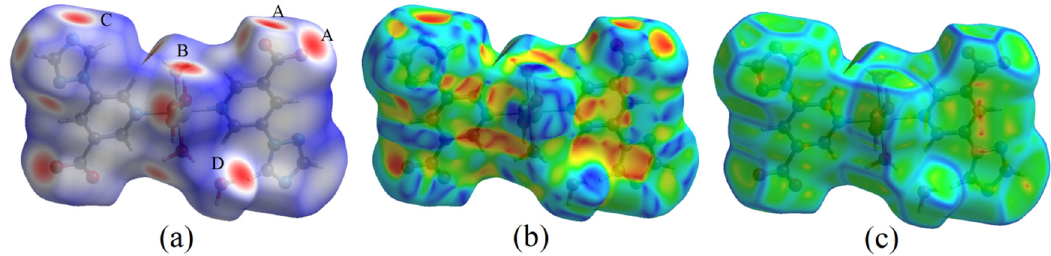
Figure 2. Hirshfeld surfaces of complex 1 mapped with ( a ) d norm , ( b ) shape index and ( c ) curvedness.